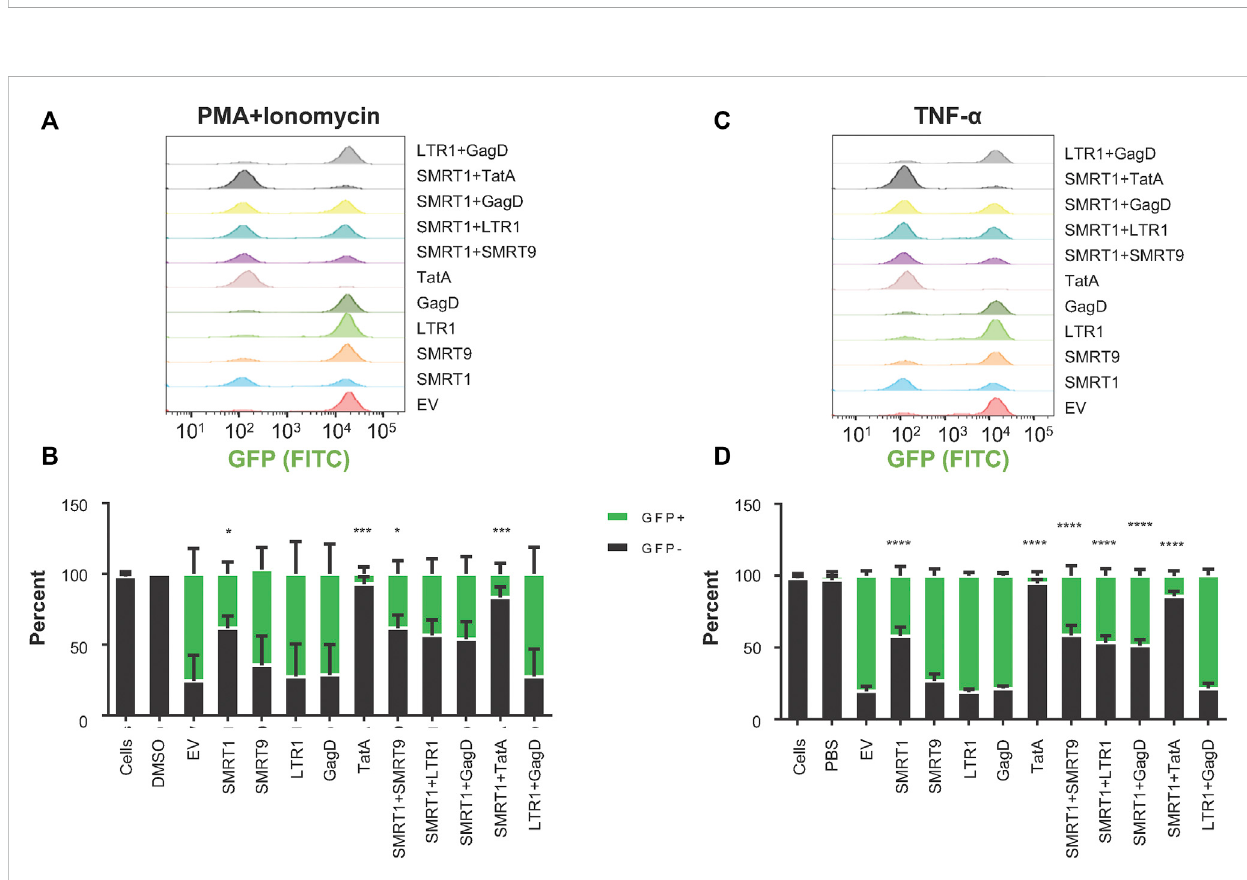
FIGURE 7 gRNAs SMRT1 and TatA were the most effective at stopping latency reversal in a T-cell model of HIV-1 latency. J-Lat 10.6 cells were seeded at 25,000 cellsper wellina96-wellv-bottom plate. Twentyfour hours post-seeding,cells werespinoculated with LV containing differentgRNAs atanMOI of 1. Post-spinoculation, cells were allowed to incubate overnight. Cells were allowed to rest for 5 days before being stimulated with either PMA + Ionomycin (50 ng/ml, 1 µM) or TNF- α (20 ng/ml) for 24 h. Twenty four hours after stimulation cells were processed for fl ow cytometry. ( A, C ) HistogramswereusedtovisualizepopulationsthatwereGFP+orGFP-.( B,D )GroupedbargraphsrepresentcellsthatareGFP+(green)andGFP-(black). Error bars represent ± SD. Statistical signi fi cance was determined by using a One-way ANOVA with multiple comparisons. p = * < 0.05, *** < 0.001, **** < 0.0001. Data were collected from three independent